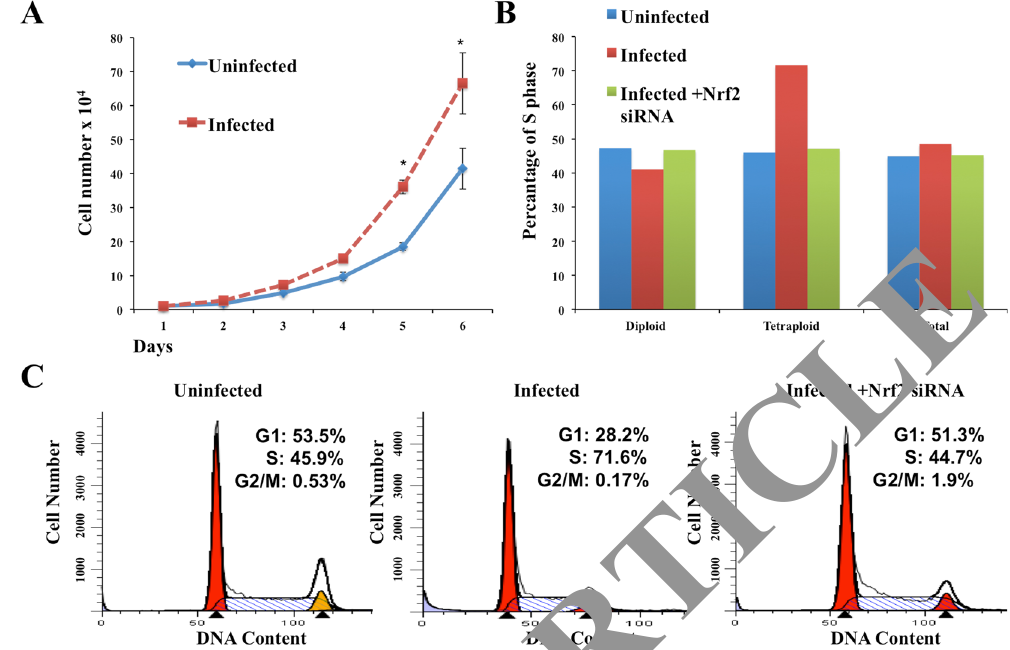
Figure 6. Persistent HCV replication in Huh-7.5 cells promotes cell growth and S-phase entry (A) HCV infected Huh-7.5 cells and uninfected cells were grown in normal growth media for 6 days. Cell numbers were counted daily. Results were shown as mean and standard error from three different experiments. (B) Show percentage of S-phase cells in diploid and tetraploid cell population. Rb loss in HCV culture shows an increase in tetraploidy population. Nrf2 silencing using two siRNAs in infected culture decreased tetraploidy population. (C) HCV infected (day 12) and uninfected Huh-7.5 cells were subjected to cell cycle analysis after propidium iodide staining. There is an increase in S-phase of cell cycle due to Rb loss in HCV infected cells. Silencing Nrf2 using two siRNAs decreased S-phase